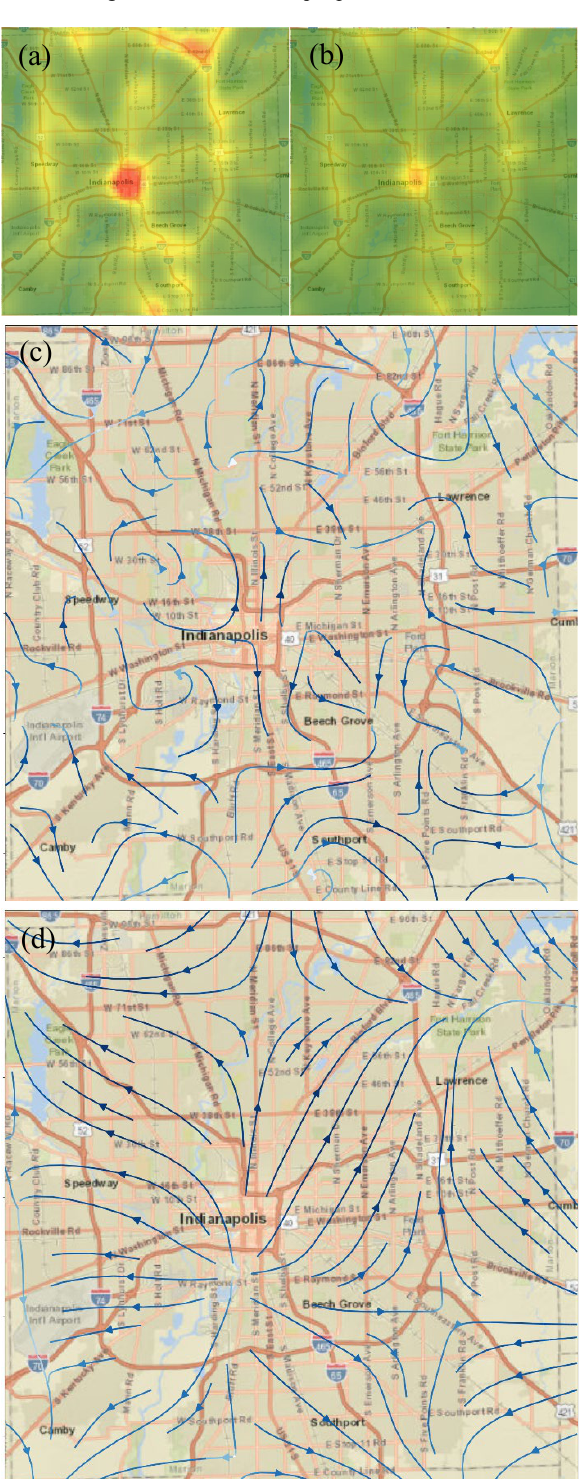
Figure 4. Heat map before and after evening rush hour. (a) Heat map at 17:00. (b) Heat map at 18:00. (c) Flow map during evening rush hour with W = 15. (d). Flow map during evening rush hour with W =